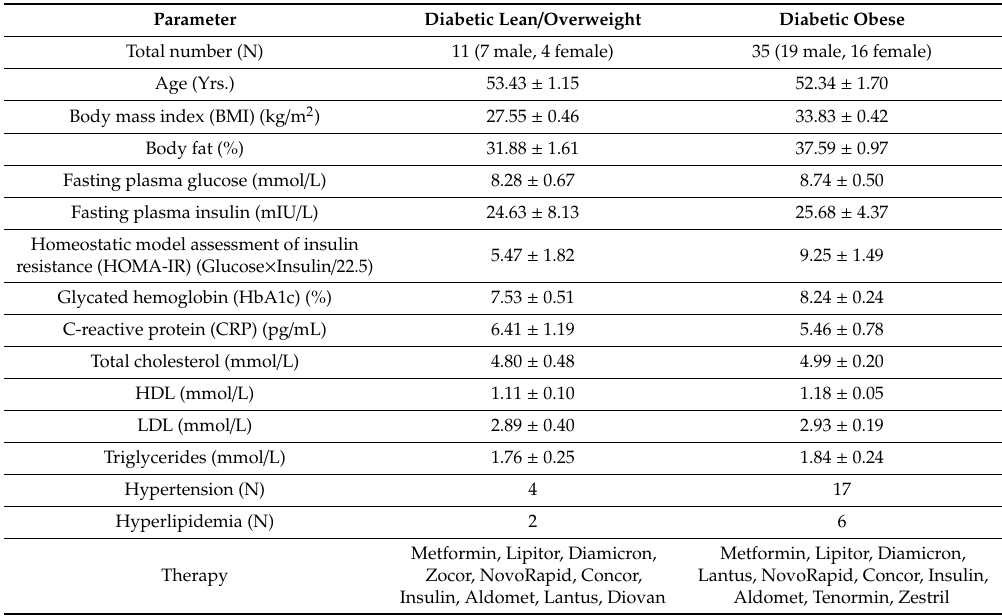
Table 1. Patients’ characteristics and clinical